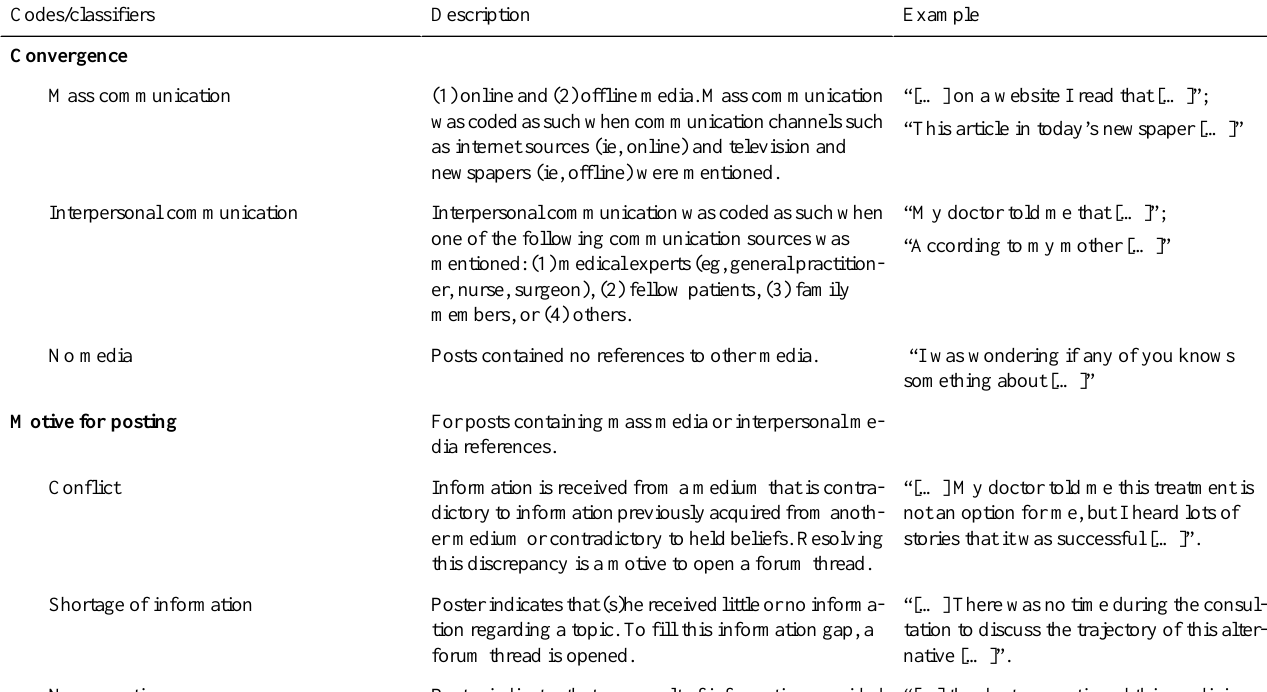
Table 1. Overview of categories and codes